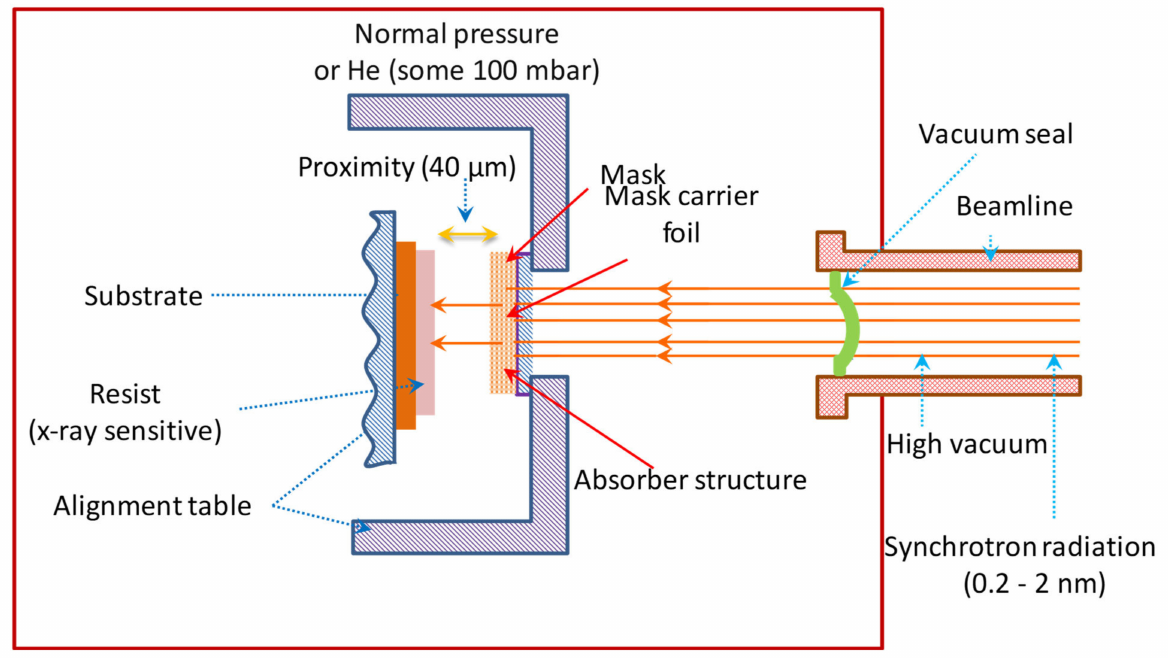
Figure 12. Schematic view of the X-ray lithography